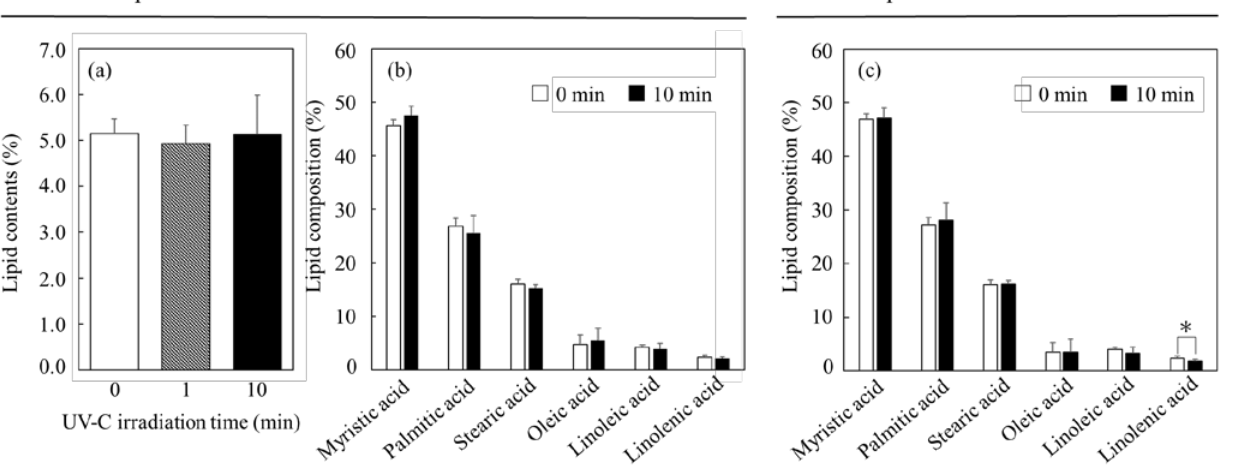
Figure 3. Effects of UV-C irradiation on lipids. The cells at 7.8 × 10 6 cells · mL − 1 were treated with UV-C irradiation in this study. Lipid contents and compositions in the cells are shown in ( a , b ). In ( a ), showing the lipid contents of the cells, the bars of white, gray and black show the contents at 0 min, 1 min and 10 min of UV-C irradiation, respectively (n = 3). In ( b ), showing the lipid compositions of the cells, the bars of white and black show the compositions at 0 min and 10 min of UV-C irradiation (n = 3). On the other hand, the lipids extracted from the 1.6 × 10 7 cells were treated with the same level of UV-C irradiation. In ( c ), the bars of white and black show the compositions at 0 min and 10 min of UV-C irradiation (n = 3). The symbol * meant p < 0.05.